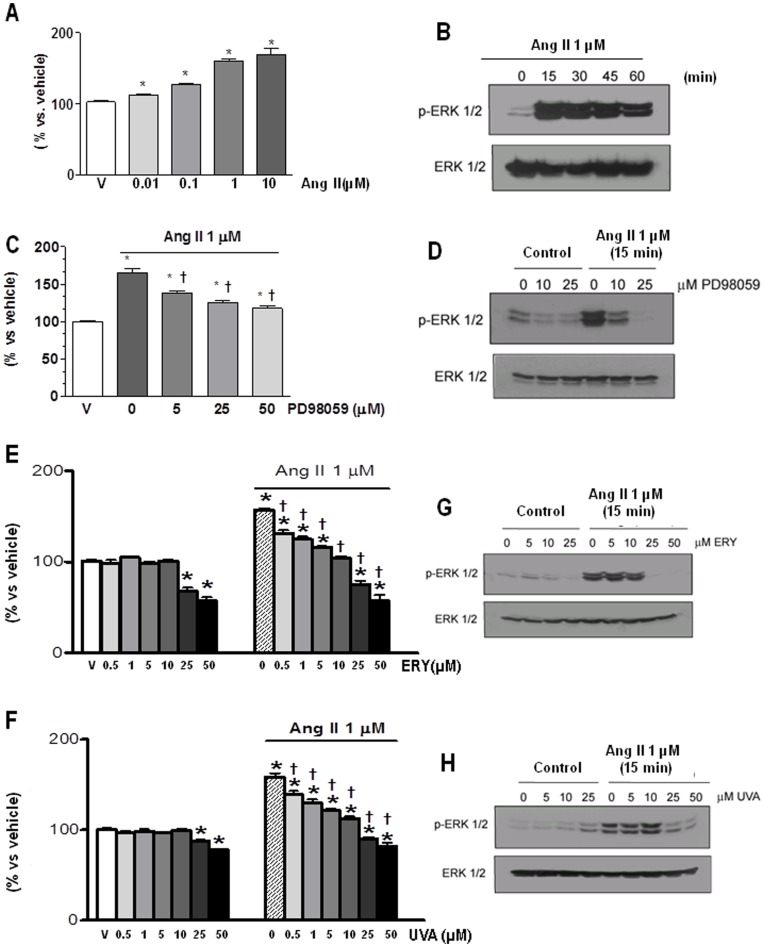
Effect of erythrodiol or uvaol on the proliferation and ERK 1/2 phosphorylation induced by angiotensin II.Cardiac myofibroblasts were stimulated with different doses of angiotensin II (Ang II; A) or with 1 µM of Ang II at different times (B). Cells in the absence or presence of different concentrations of a specific MEK inhibitor (PD98059; C and D), erythrodiol (ERY; E and G) or uvaol (UVA; F and H). After 24 h of incubation at 37°C (A, C, E and F), cell proliferation was determined by an MTT assay and expressed as percent of controls (vehicle, v). (B, D, G and H), after 15 min stimulation, whole cell lysates were extracted and protein phosphorylation was assessed by Western blotting using phospho-ERK and total ERK antibodies. Membranes always were stained with Ponceau S as a loading control. Representative immunoblots of 3 experiments. Values are mean ± SEM of three assays; *p<0.05 vs vehicle (V). †p<0.05 vs either 0 (absence of ERY or UVA) or Ang II.